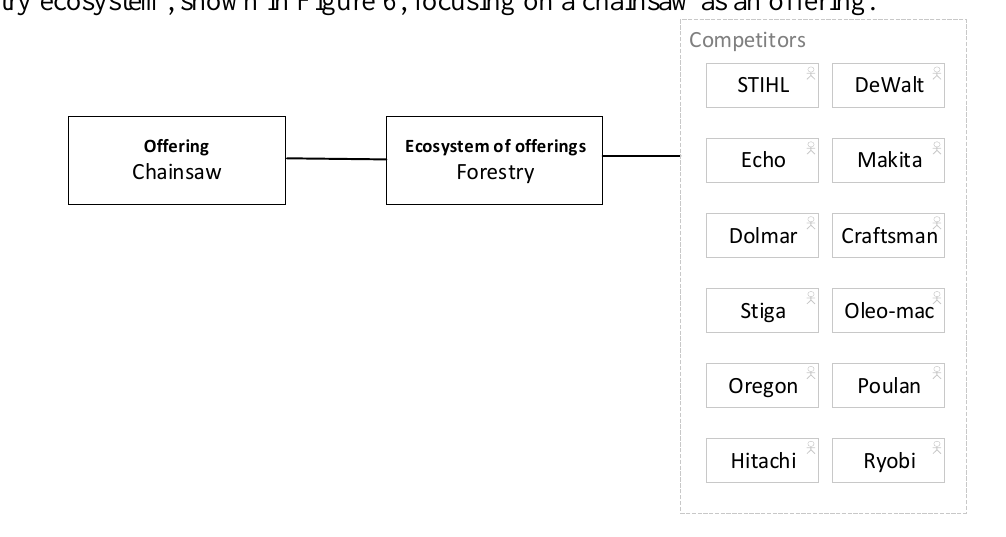
Figure 7. Key competitors in the Forestry ecosystem of offerings, chainsaw